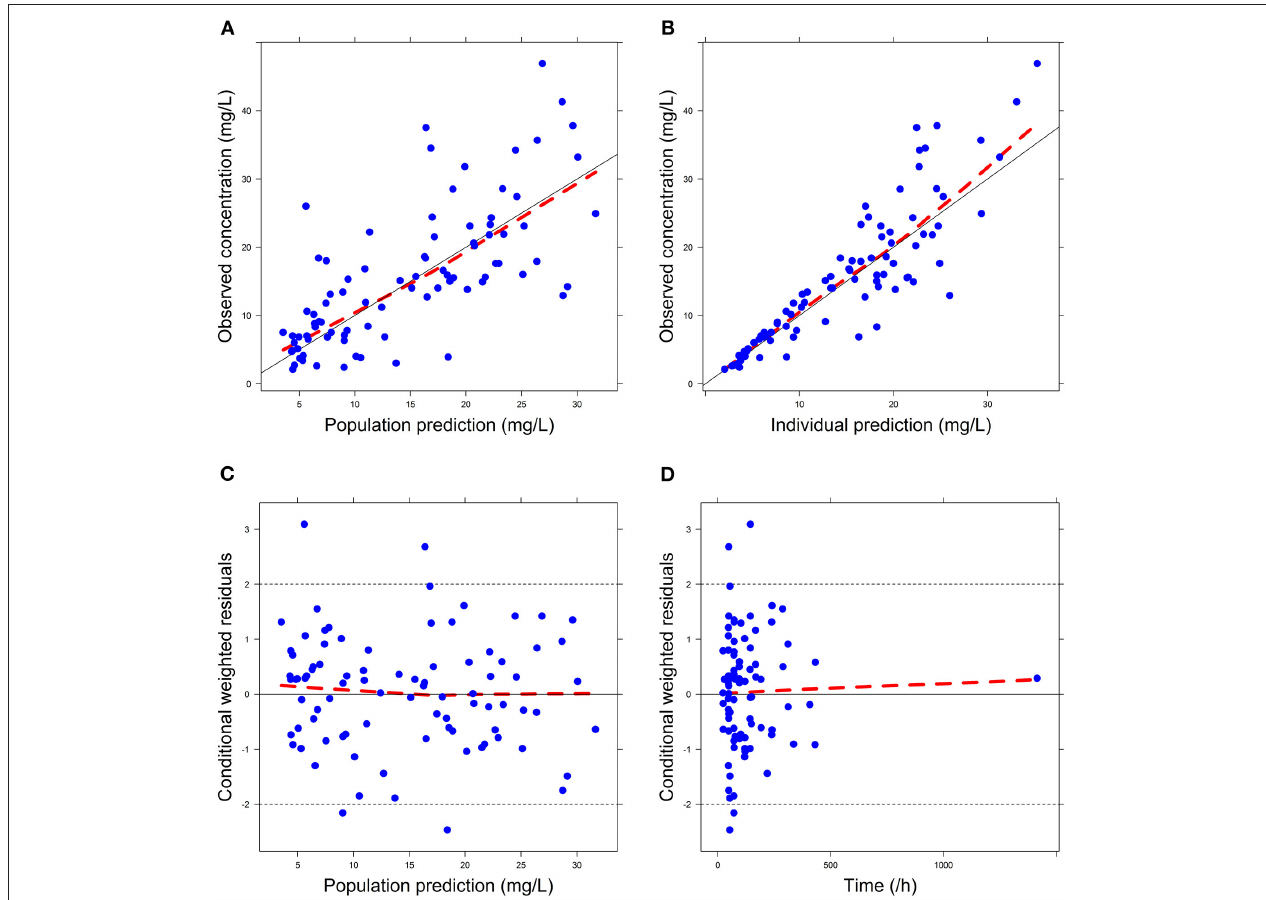
FIGURE 1 | Goodness-of-fit (GOF) plots of Model 1: (A) observed concentration (DV) vs. population prediction (PRED); (B) DV vs. individual prediction (IPRED); (C) conditional weighted residual errors (CWRES) vs. PRED; (D) CWRES vs. Time.